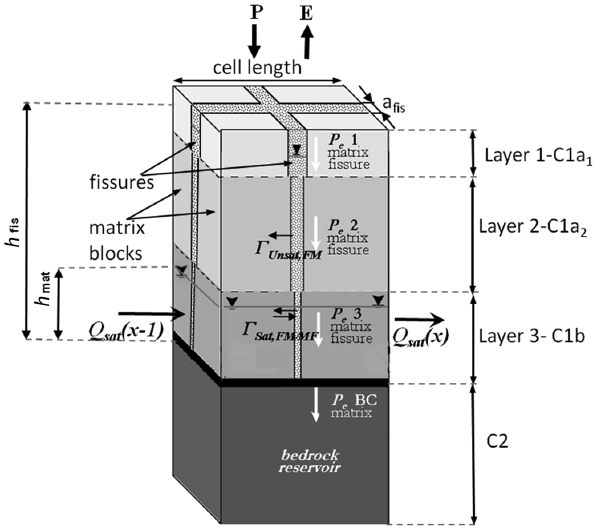
Fig. 1. Schematisation of the hydrological model of the Super- Sauze